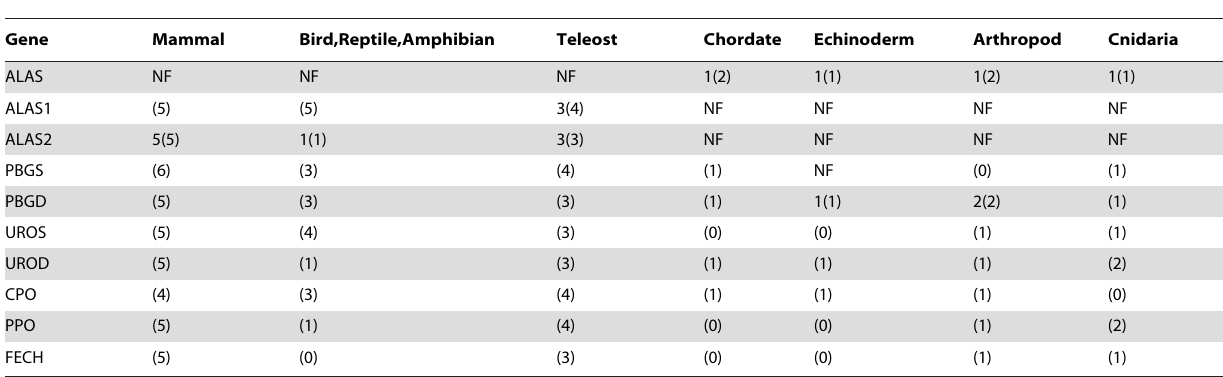
Table 4. IRE in 5 9